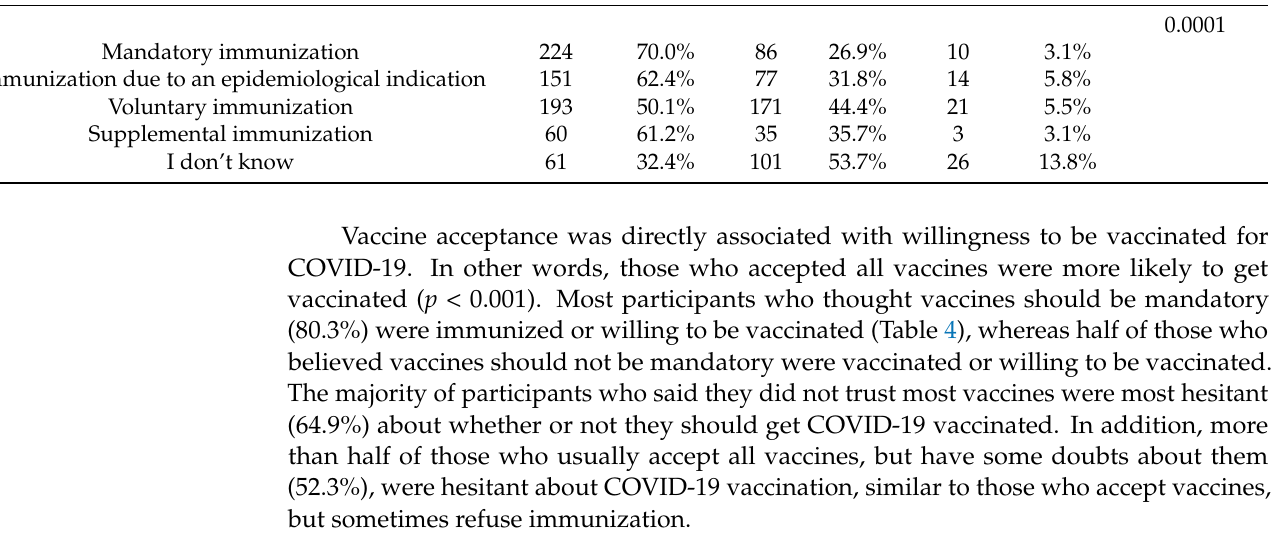
Table 4. Vaccine acceptance, personal decision, and willingness to be vaccinated for